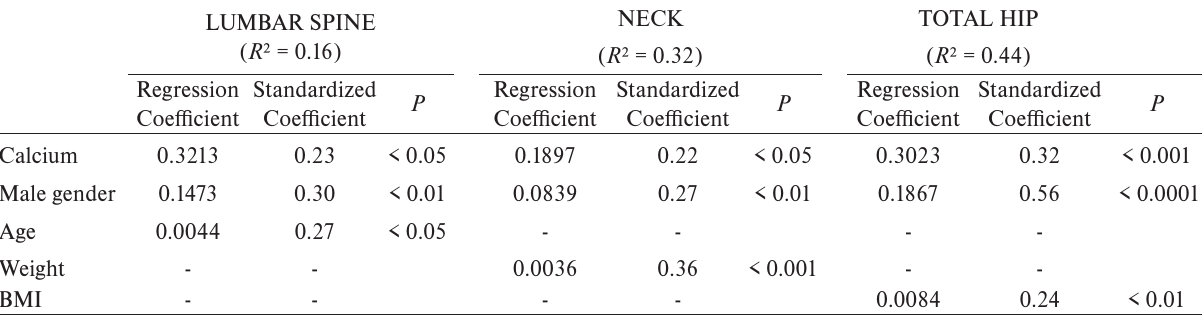
Table 5. Independent variables reaching significance from stepwise linear multiple regression analyses using lumbar spine, femoral neck and total hip BMD as dependent variables (all